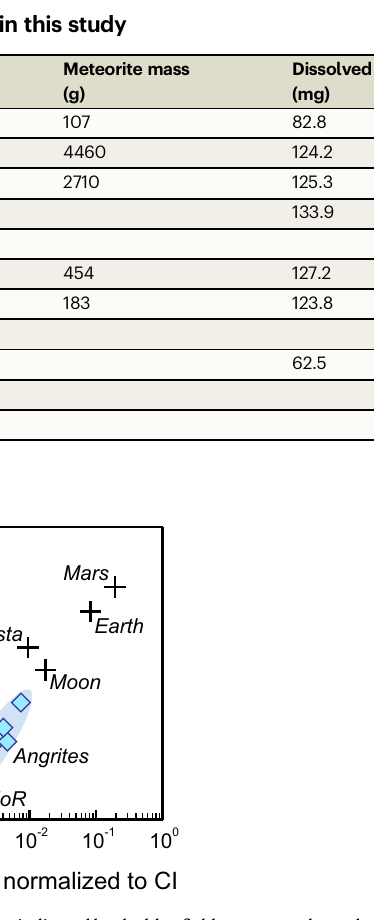
earthelements. b Angrites,asindicatedbytheblue fi eld,representtheendmember for MVE depletion among planetary basalts. The degrees of volatile depletion in AdoR,the bulksilicate Moon,Vesta,Earth,and MarsareassessedbyCI-normalized Rb/Sr and K/U ratios from ref.